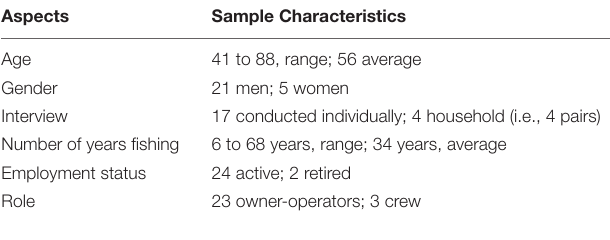
TABLE 1 | Research participant overview at the time of